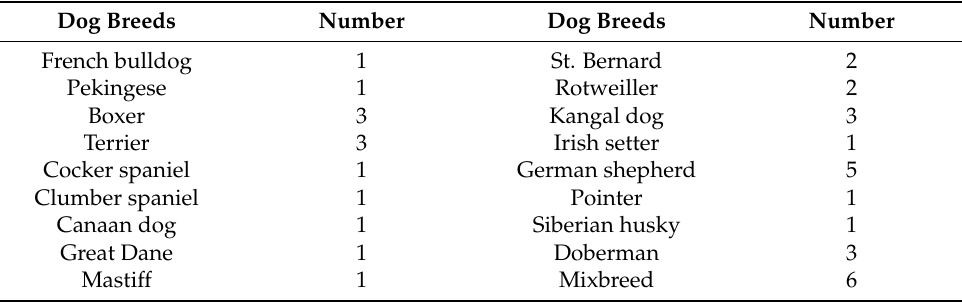
Figure 3. A large composition of animal bones with hearth fragments unearthed at the western section of Alaybeyi Höyük. Table 1. List of the modern dog breeds used in comparison with Alaybeyi dogs. Dog Breeds Number Dog Breeds Number French